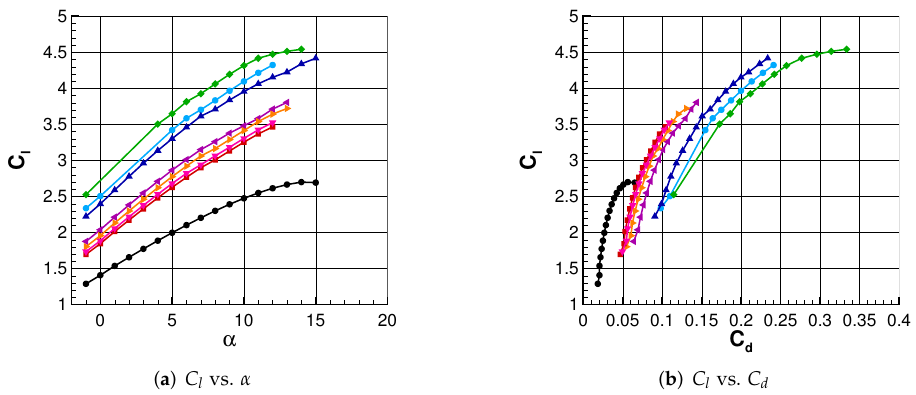
Figure 6. Polar curves comparison of the test cases d / c = 0.802 with respect to power-off condition ( ● ) . Test case A1 ( ■ ) , B1 ( ▼ ) , C1 ( ▶ ) , D1 ( ◀ ) , E1 ( ▲ ) , F1 ( ● ) , and G1 ( ◆ )